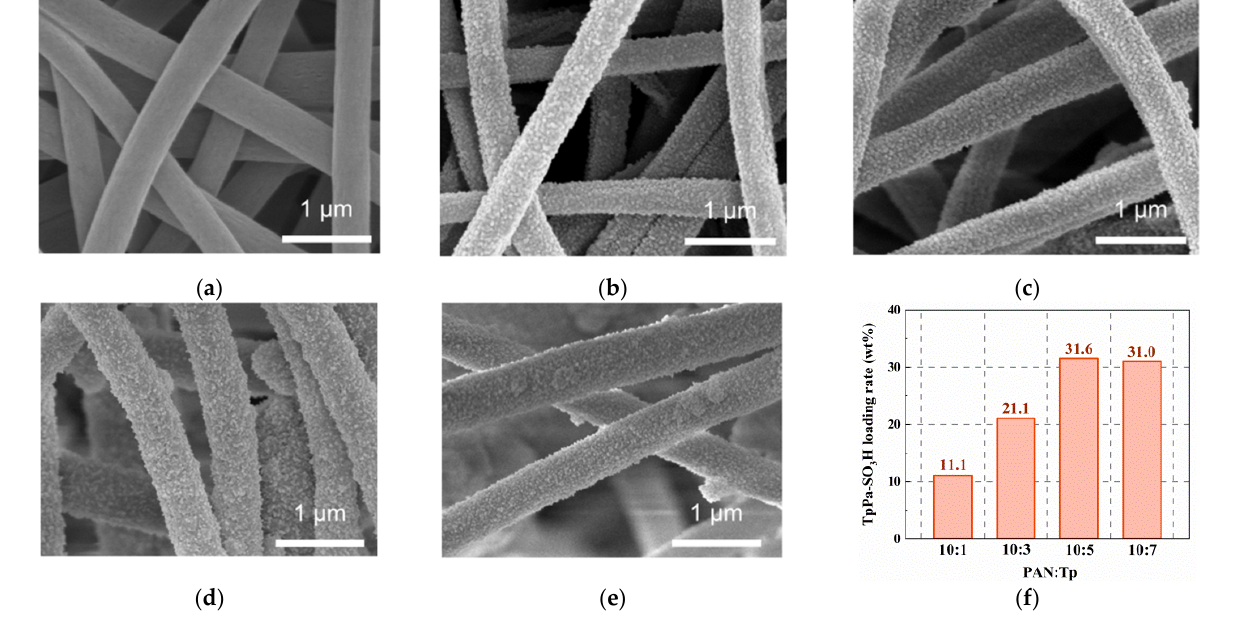
Figure 1. The SEM images of PAN and PAN/TpPa ‐ SO 3 H nanofibers: ( a ) PAN, ( b ) PAN:Tp = 10:1, ( c ) 10:3, ( d ) 10:5 and ( e ) 10:7 after reaction at 90 °C for 3 days, respectively; ( f ) TpPa ‐ SO 3 H loading on nanofiber surface of different PAN:Tp ratio.